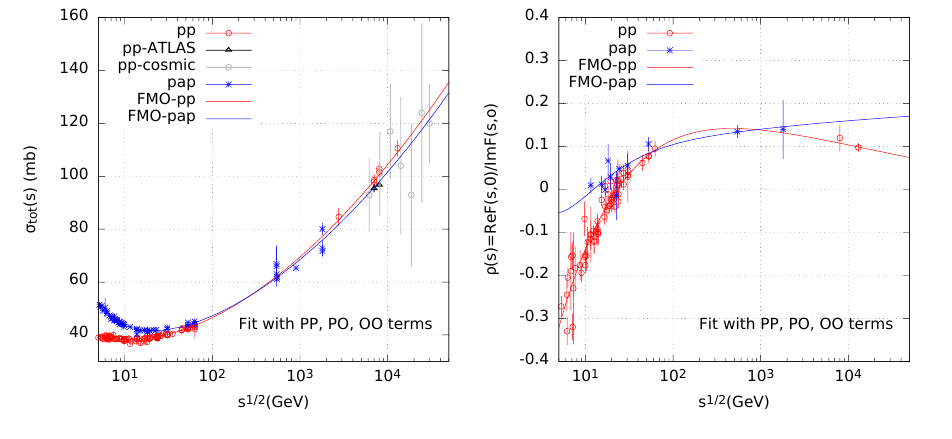
Figure 2. Total pp and ¯ pp cross sections (left panel) and ratios ρ pp and ρ ¯ pp (right panel) in the FMO